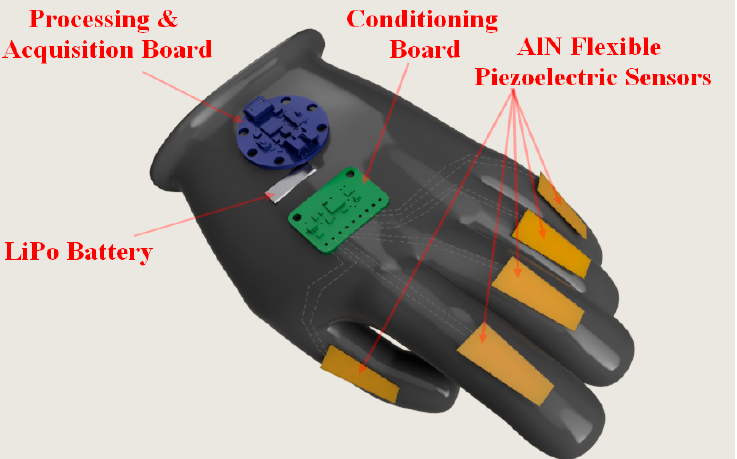
Figure 22. Three-dimensional model of the developed piezoelectric glove with highlighted the main components: AlN flexible sensors, conditioning board, acquisition and processing board, and Lipo